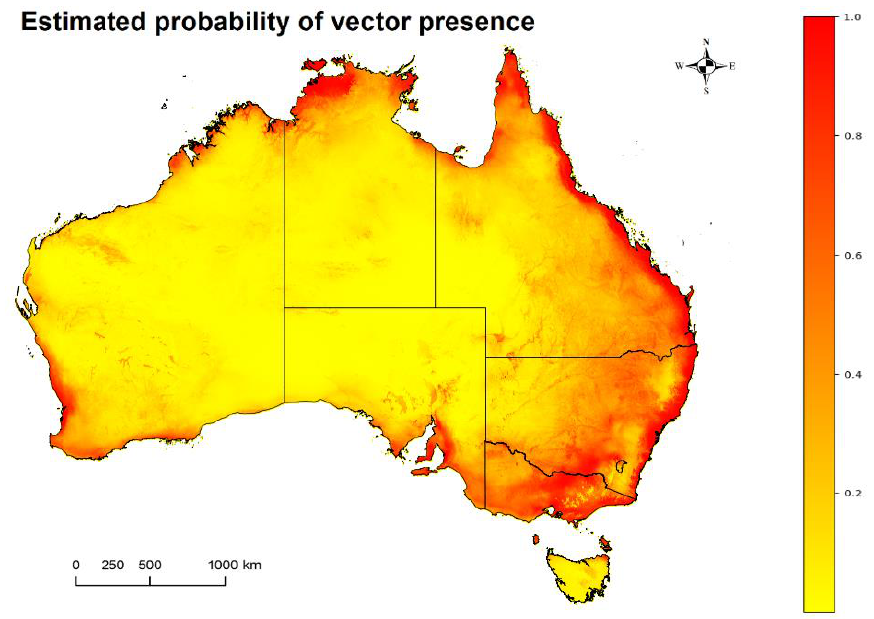
Figure 1. The combined estimated distribution of vectors suspected to be competent for JEV transmission in Australia ( Cx. annulirotris , Cx. quinquefasciatus , Cx. sitiens ), where the probability of presence ranges from zero (white: none apparent) and low (yellow) to high (red). A combined presence estimate based on ENMs of all the twelve waterbird species considered potential JEV reservoirs (see Table S1) is shown in Figure 2. The estimated probability of presence was low within the parts of the Great Victorian, Gibson and Great Sandy Deserts. Overall, waterbirds are estimated to have a wide distribution across the continent, including notably among inland regions in Queensland (QLD), New South Wales (NSW) and the Northern Territory (NT).